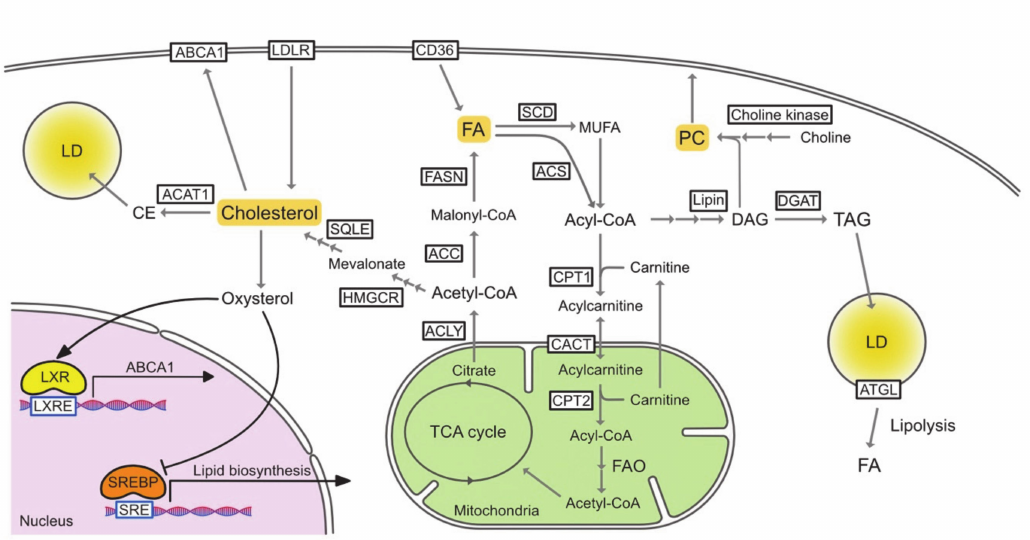
Figure 1. The pathways of lipid metabolism. ABCA1, ATP-binding cassette transporter A1; ACAT1, acetyl-CoA acetyl- transferase 1; ACC, acetyl-CoA carboxylase; Acetyl-CoA, acetyl-coenzyme A; ACLY, ATP citrate lyase; ACS, acyl-CoA synthetase; Acyl-CoA, acyl-coenzyme A; ATGL, adipose triglyceride lipase; CACT, carnitine acylcarnitine translocase; CE, cholesterol ester; CPT1, carnitine palmitoyltransferase 1; CPT2, carnitine palmitoyltransferase 2; DAG, diasylglycerol; DGAT, diglyceride acyltransferase; FA, fatty acid; FAO, fatty acid oxidation; FASN, fatty acid synthase; HMGCR, 3-hydroxy-3- methylglutaryl-CoA reductase; LD, lipid droplet; LDLR, low-density lipoprotein receptor; LXR, liver X receptor; LXRE, LXR response element; MUFA, monounsaturated fatty acid; PC, phosphatidylcholine; SCD, stearoly-CoA desaturase; SRE, sterol regulatory element; SREBP, sterol regulatory element-binding protein; SQLE, squalene epoxidase; TAG, triacylglycerol; TCA, tricarboxylic acid.